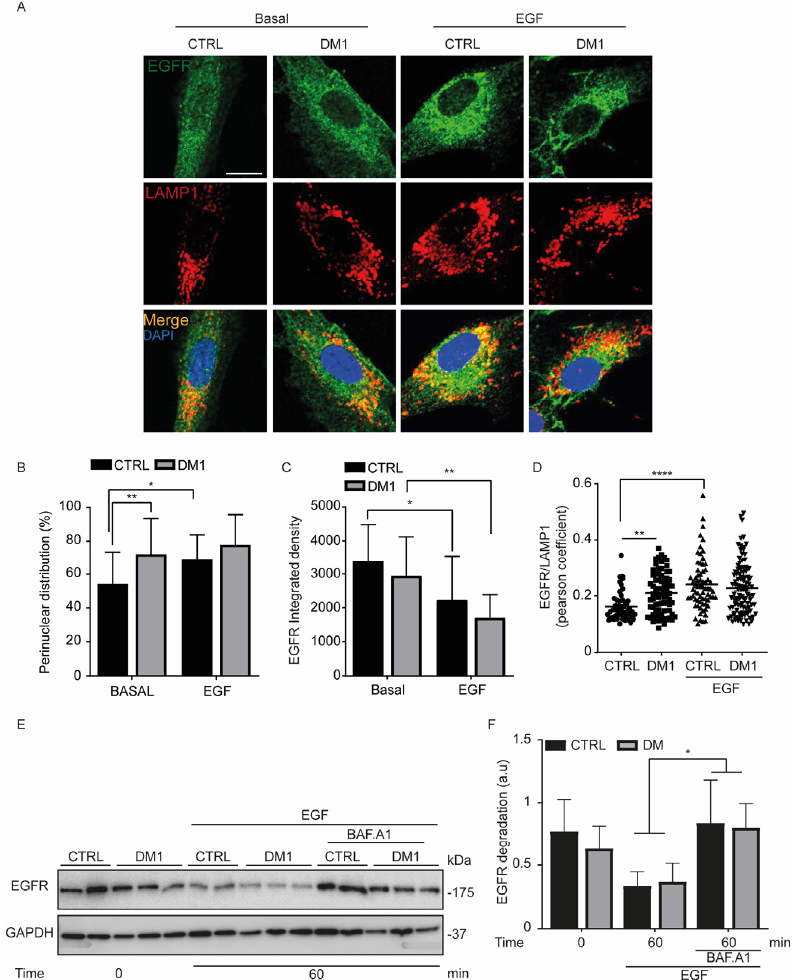
Figure 7. EGF-induced EGFR is sorted into lysosomes. ( A – D ) Serum-starved cells were incubated with 100 ng/mL EGF for one hour. ( A ) Cells were co-labeled with EGFR and LAMP1 antibodies. Nuclei were stained with 300 nM DAPI (scale bar is 10 µ m; original magnification is × 60). ( B ) The perinuclear distribution of EGFR that was determined by manual counting, n = 80–100 cells (* p < 0.05, ** p < 0.01 two-way ANOVA Tukey’s test). ( C ) The fluorescence intensity of EGFR represented as integrated density from ImageJ software (** p < 0.01, **** p < 0.0001 two-way ANOVA Tukey’s test). ( D ) Reflects the co-localization between EGFR/LAMP1 using Pearson’s coefficient (** p < 0.01, **** p < 0.0001 with two-way ANOVA). All experiments were performed at least two times. ( E , F ) Serum-starved